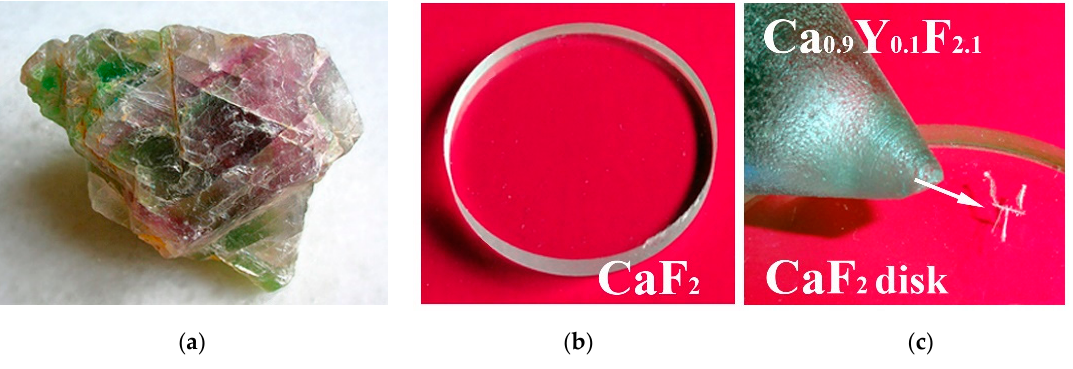
Figure 1. Yttrofluorite mineral ( a ), artificial CaF 2 ( b ) and engraving on CaF 2 with Ca 1– x Y x F 2+ x ( c ).